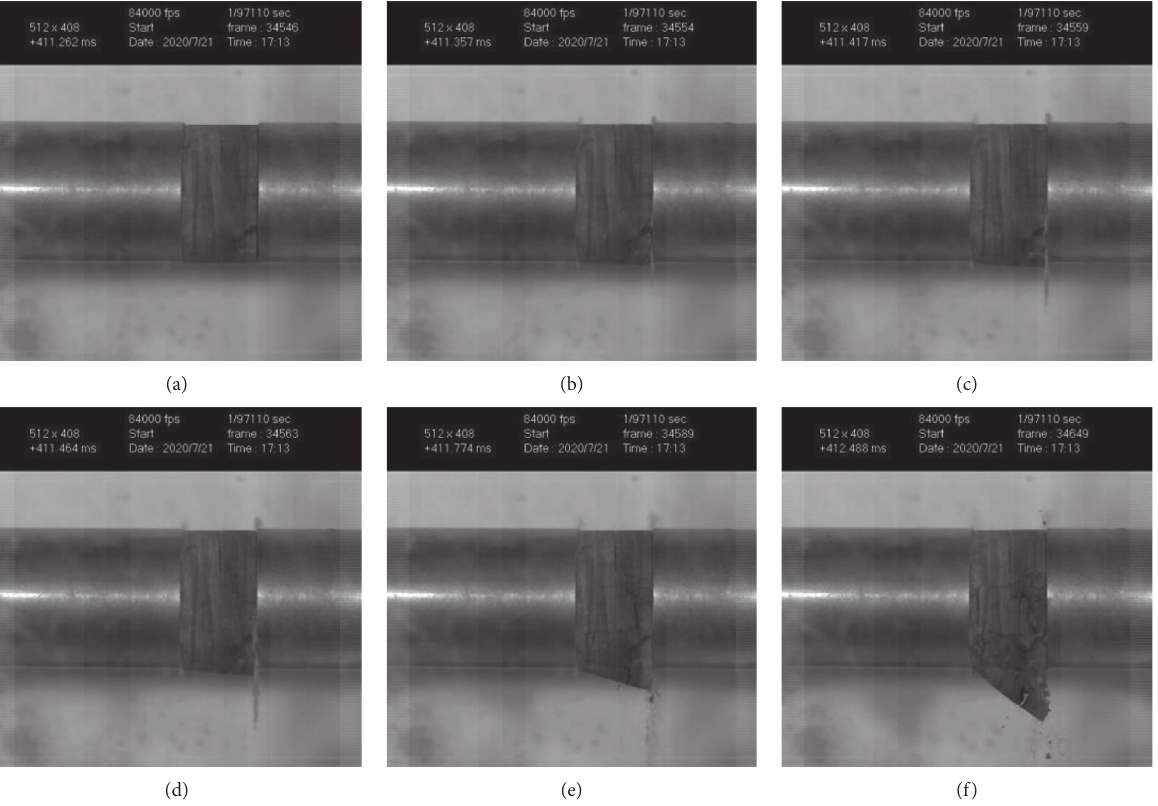
Figure 13: Failure of crack specimen filled with epoxy resin. (a) 0 us, (b) 95us, (c) 155us, (d) 202us, (e) 512 us, and (f)